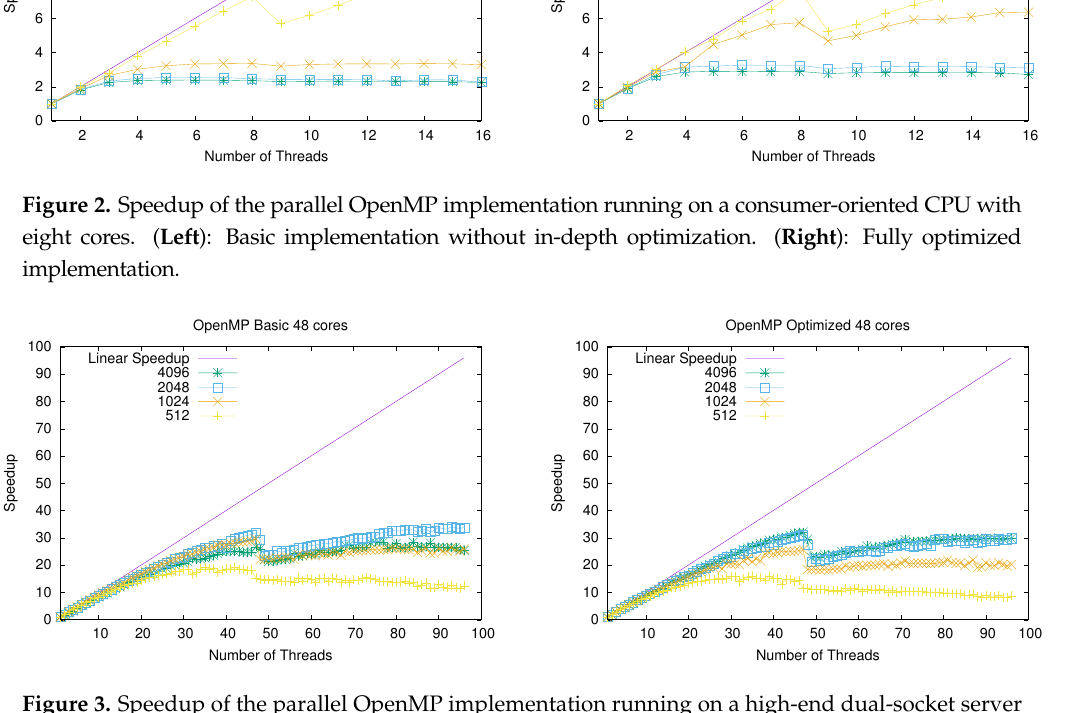
Figure 3. Speedup of the parallel OpenMP implementation running on a high-end dual-socket server with a total of 48 cores. ( Left ): Basic implementation without in-depth optimization. ( Right ): Fully optimized implementation.